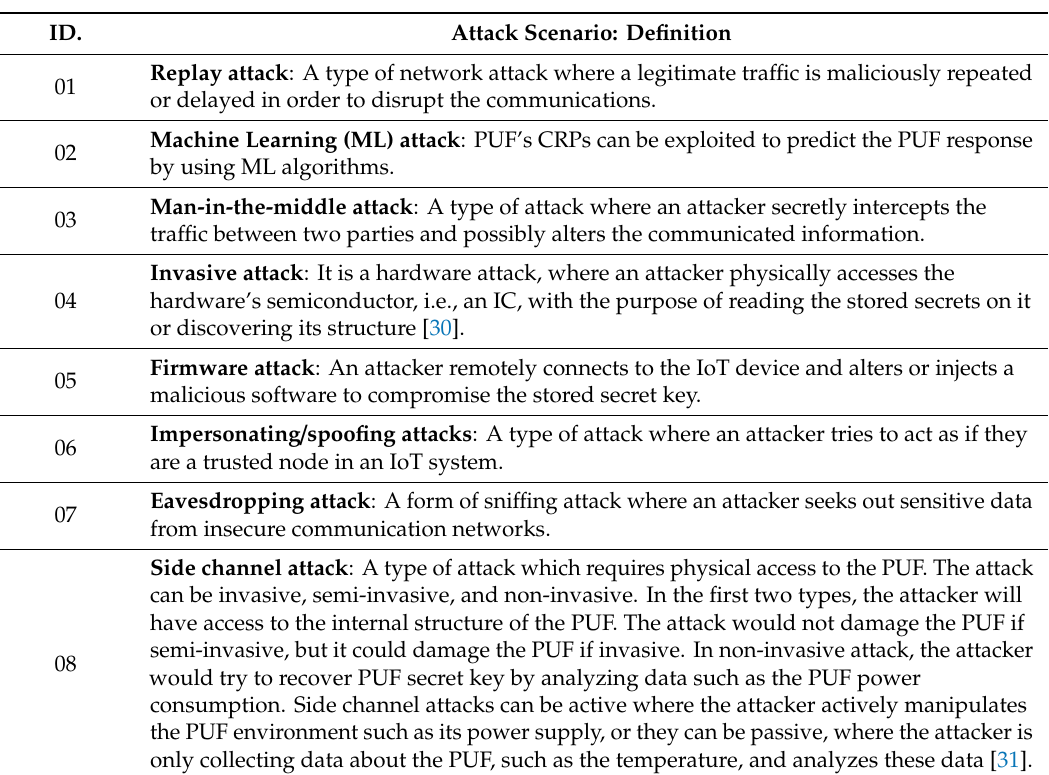
Table 2. Cyberattack scenario